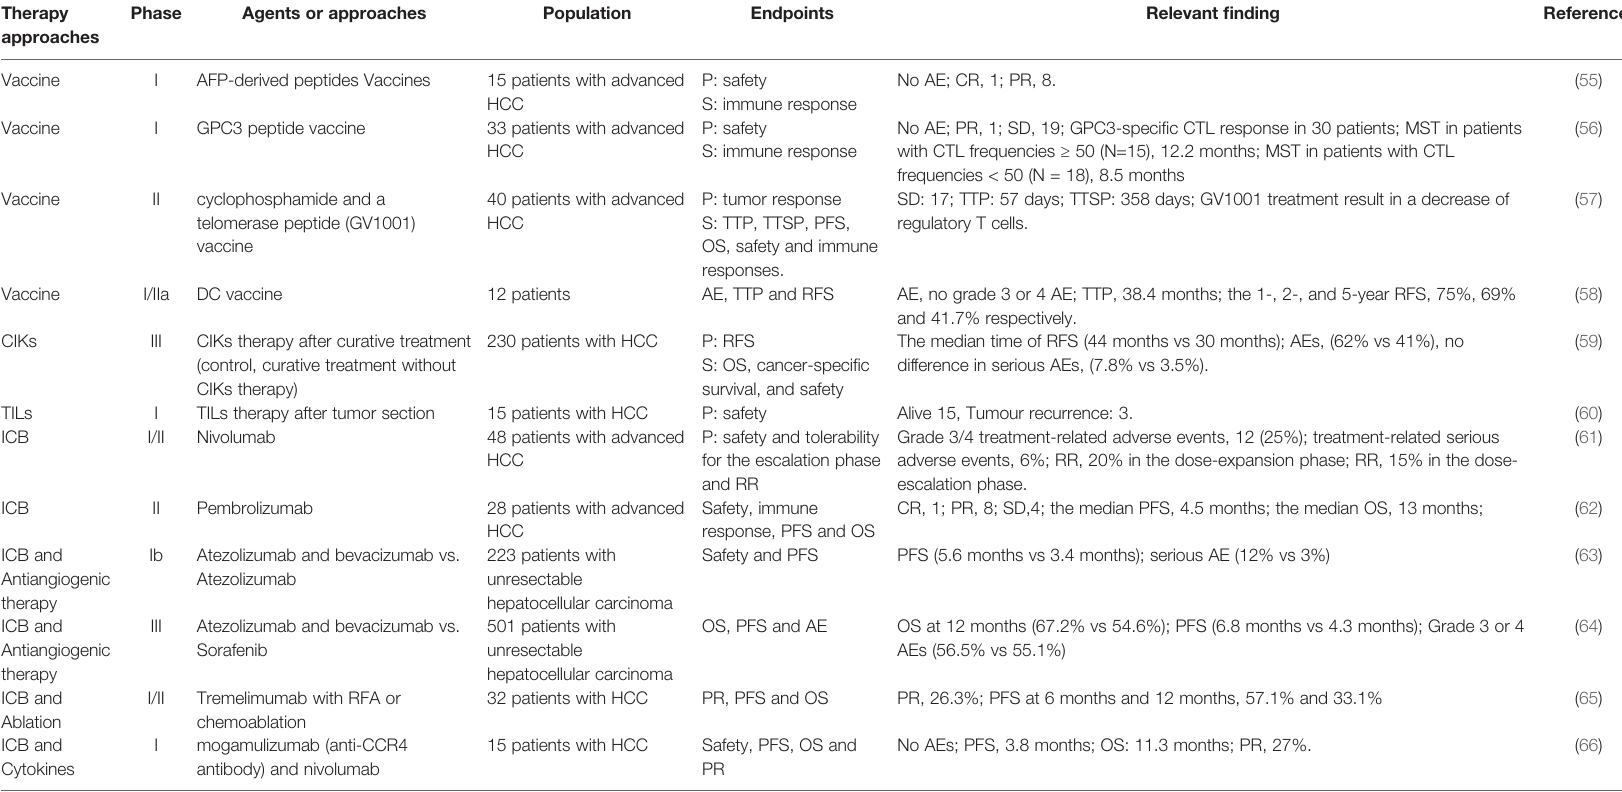
TABLE 1 | Clinical trials of immunotherapy for